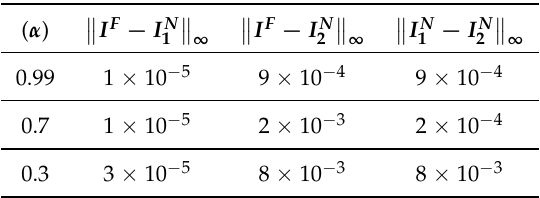
Table 1. Comparison of the L ∞ -norm between the solutions computed with the three methodologies for different values of α